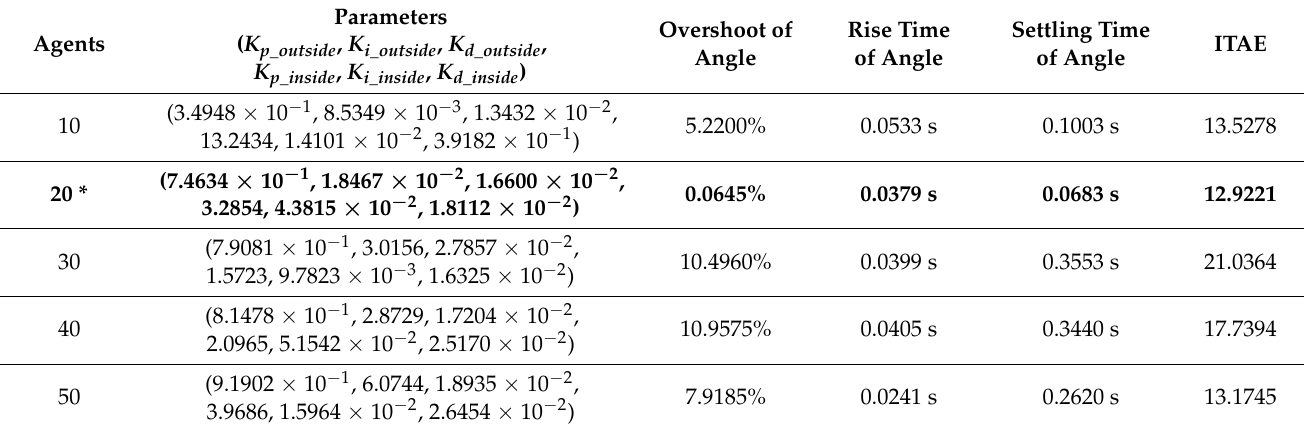
Table 4. Attitude control of balancing robots under AOA-PID